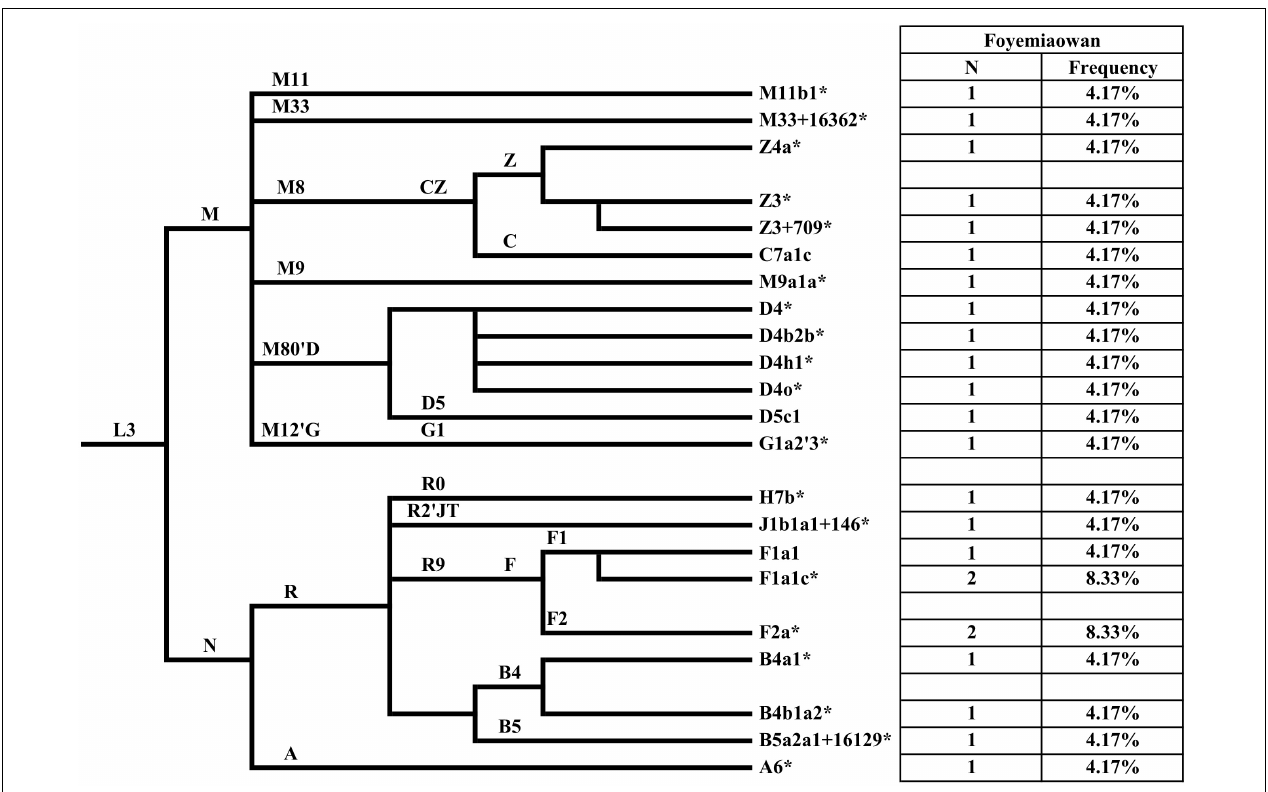
FIGURE 3 | The phylogenetic relationship of mtDNA haplogroups surveyed in this study and their haplogroup-based frequencies in the sampled populations, with haplogroup names shown on the right. Asterisks distinguish potentially paraphyletic undefined subgroups from recognized